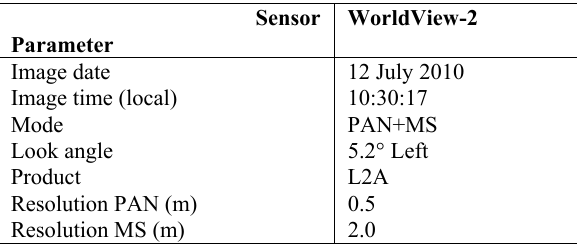
Table 5. Scene parameters for WorldView-2 data over the city of Munich,